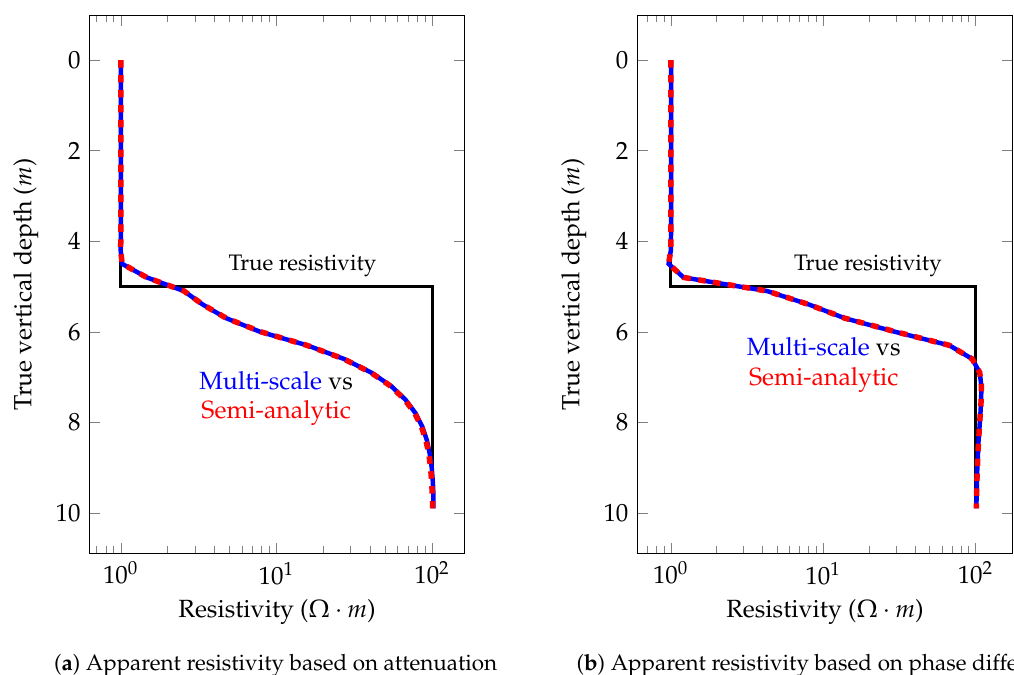
Figure 7. Model problem 1. Apparent resistivities for the zz coupling for a vertical well (dip angle = 0 ◦